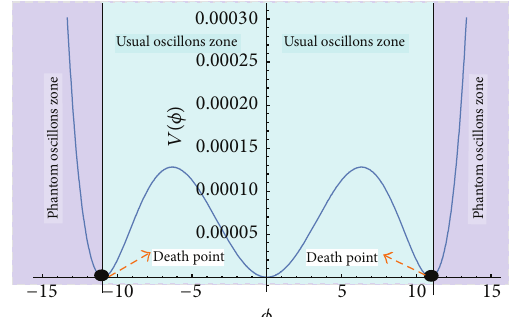
Figure 1: Profile of the potential of the model on analysis with 𝑎 = 1.2 , 𝑏 = 0.01 , and 𝜆 = 10 −5